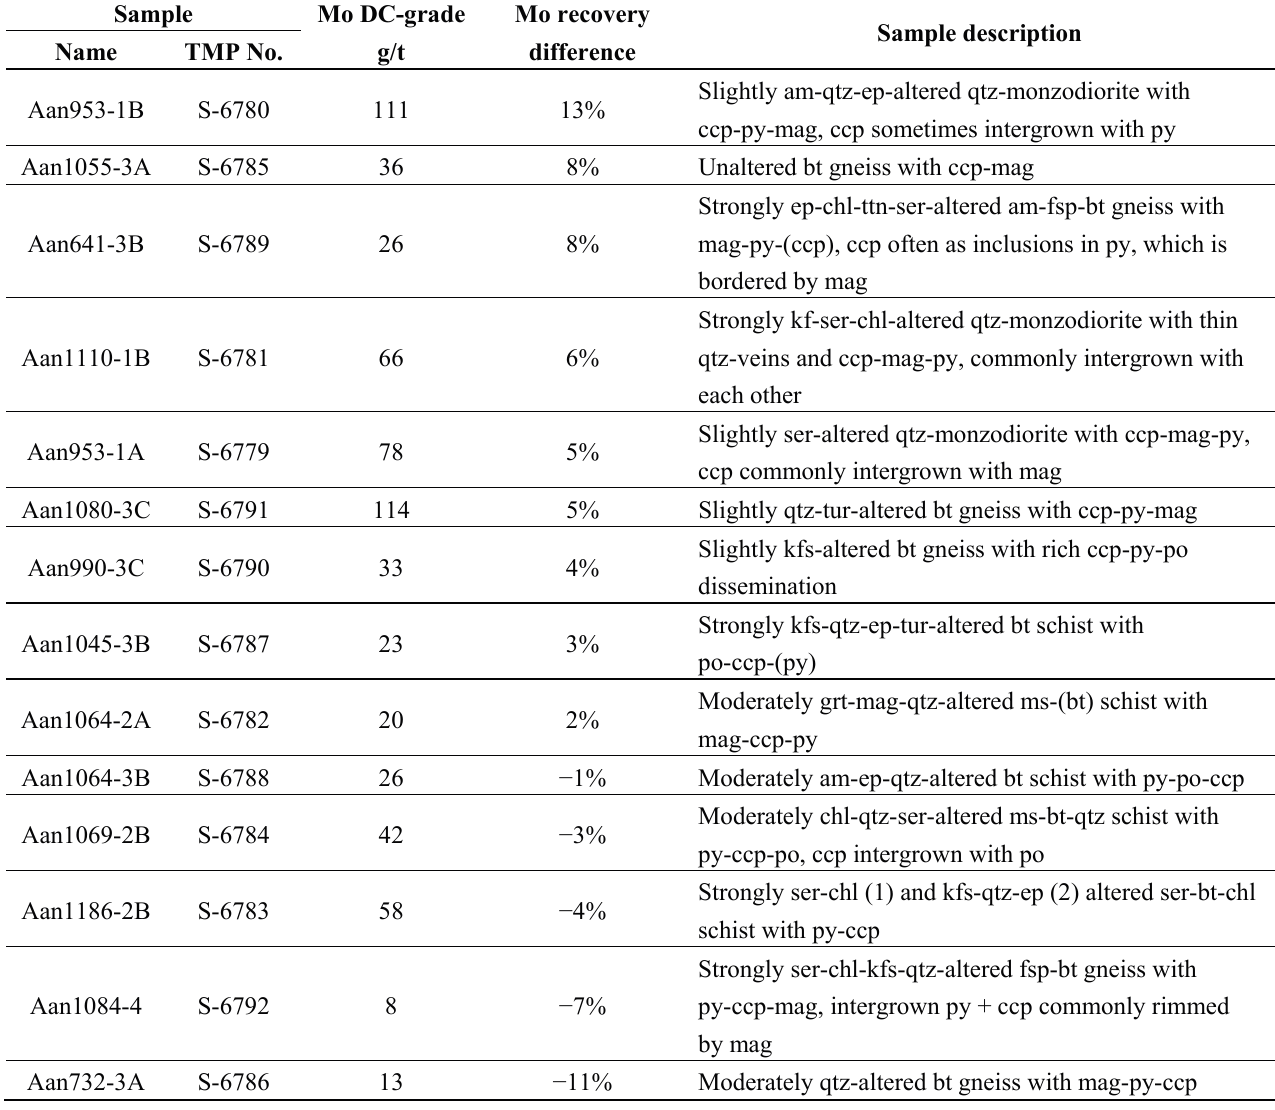
Table 2. Drill core flotation test samples, listed after Mo flotation recovery, difference from average. Sample TMP